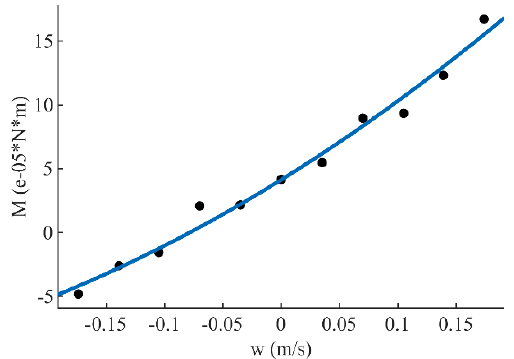
Figure 10. Fitted curve of pitching moment N and angular velocity r.